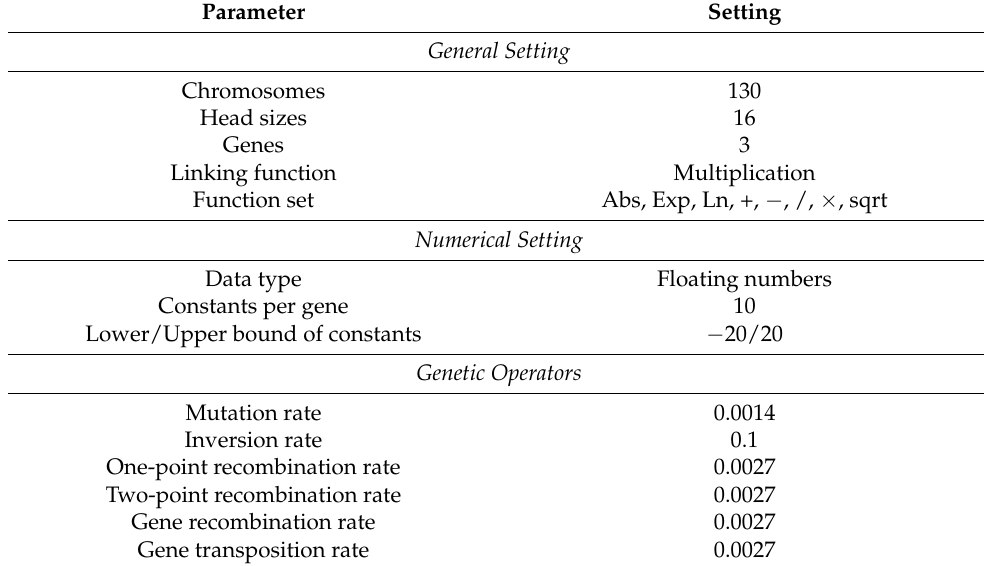
Table 2. Parameters setting for GEP